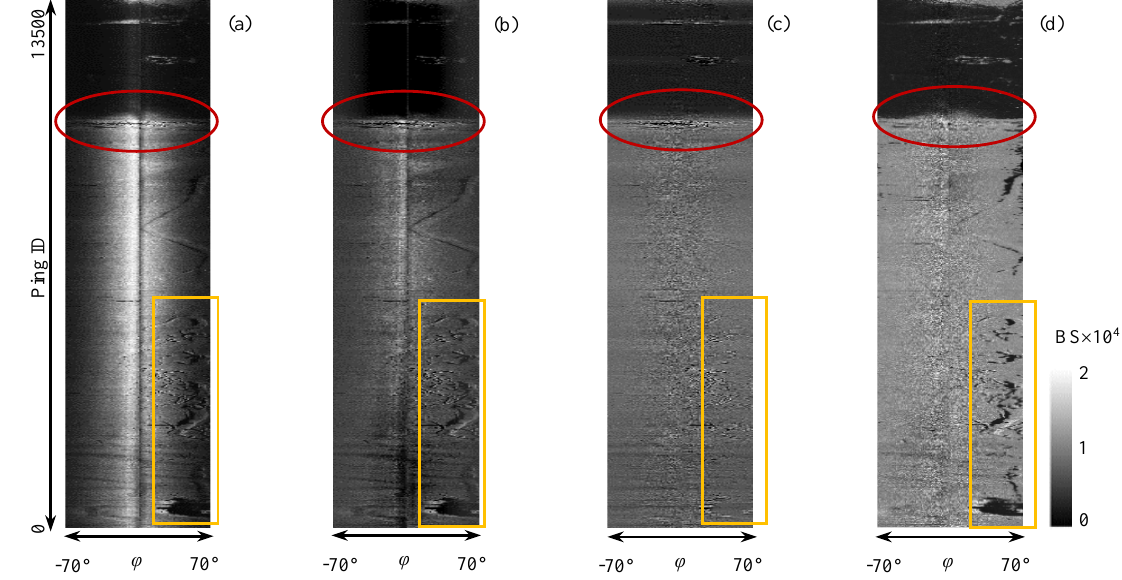
Figure 11. Comparisons of different radiometric corrections. φ denotes the incident angle: ( a ) raw SSS image; ( b , c ) results corrected by the average angle–BS curves of the entire line and every 50 pings, respectively; and ( d ) result corrected with the proposed method. The red ellipse denotes the sediment transition region, and the yellow rectangle shows the micro sediment variation.